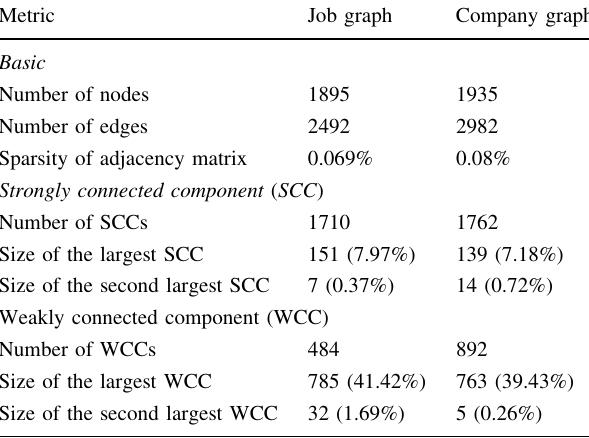
Table 9 Network statistics of the Hong Kong dataset